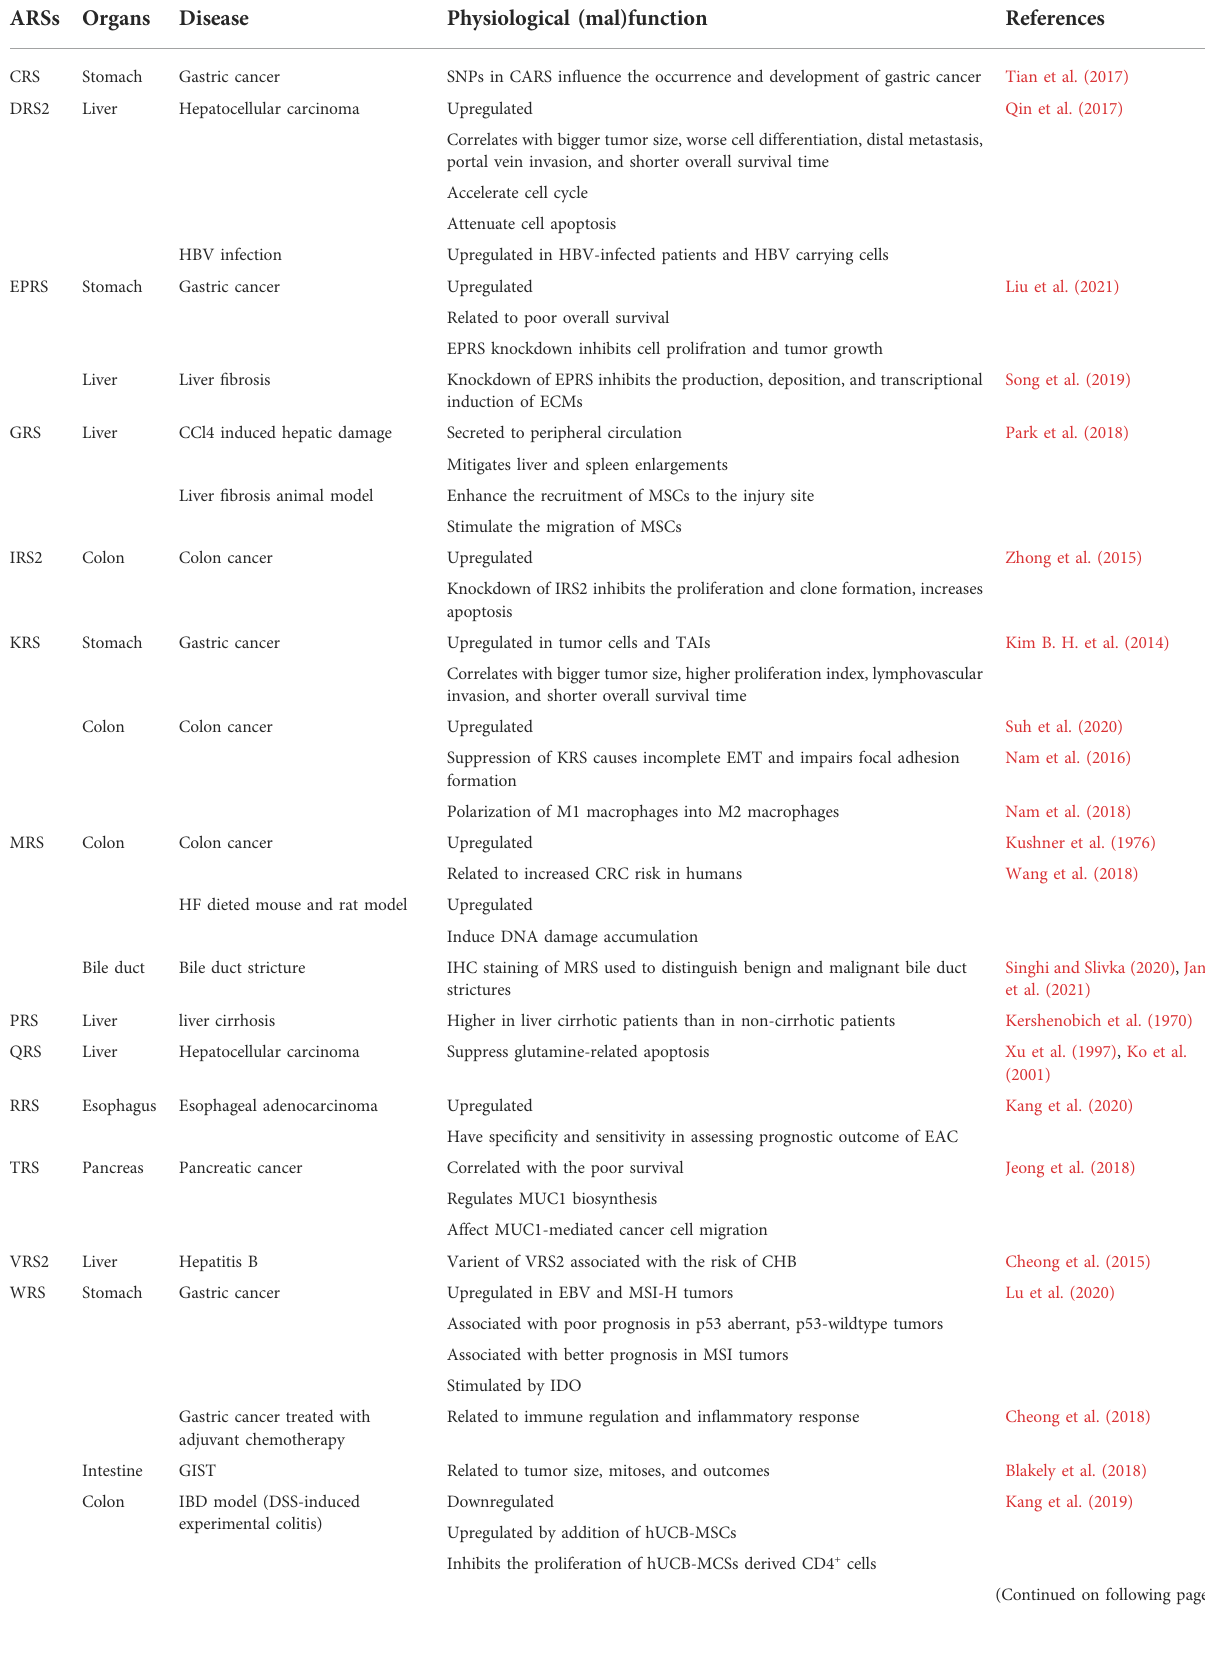
TABLE 1 ARSs and their pathological